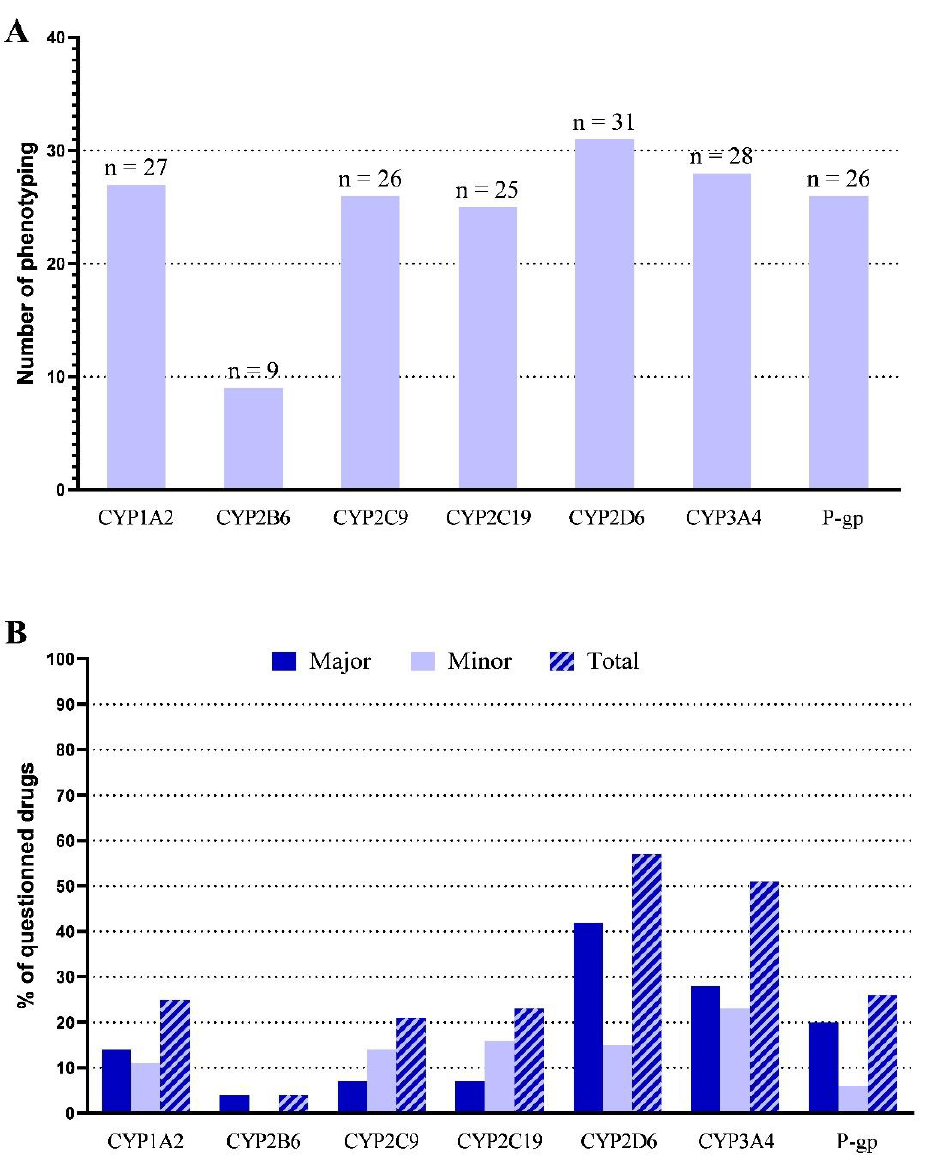
Figure 2. ( A ) Implications of the different CYP/P-gp profiles with the 32 phenotypings and ( B ) proportion of drugs that are minor (light blue) or major (dark blue) substrates of the CYP/P-gp profiles among the 224 cumulated drugs implicated in the therapeutic problem that led to the 32 phenotypic assessments (n = 224 cumulated drugs = sum of all drugs involved in each of the 32 phenotypings; a drug involved in more than one phenotyping was counted cumulatively for as many times as the phenotypings).